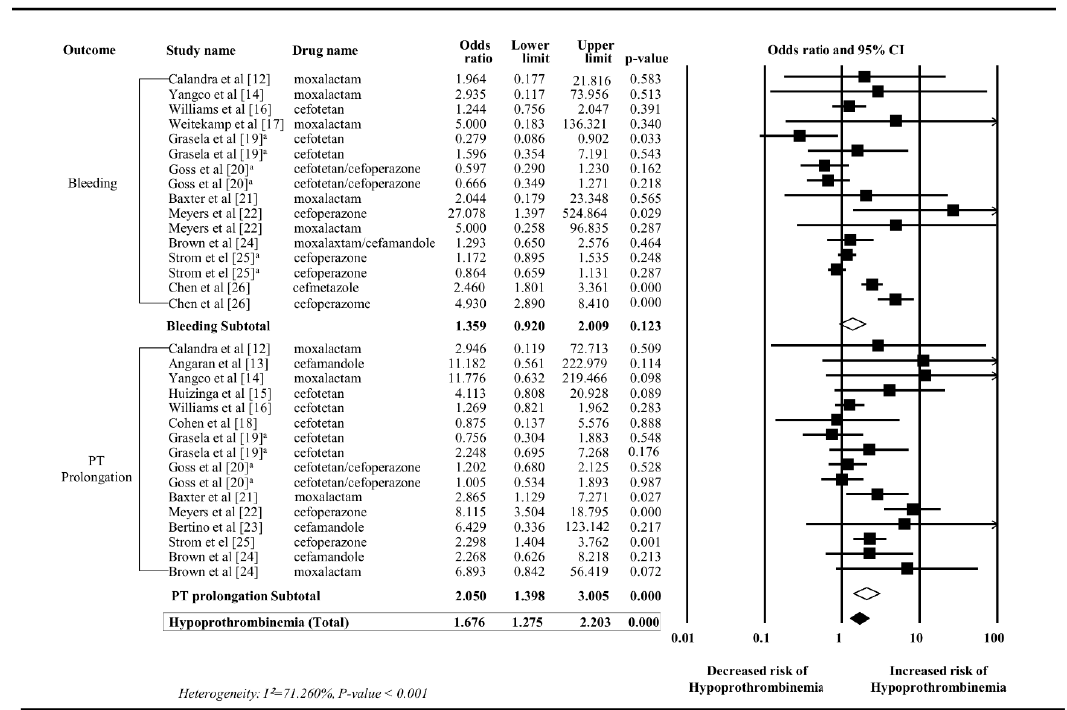
Figure 3. Forest plots of odds ratio for bleeding, PT prolongation, and hypoprothrombinemia associated with NMTT-cephalosporin compared with non-NMTT-cephalosporin. NMTT, N-methylthiotetrazole side chain. a Multiple control groups from the study were treated independently in the meta-analysis.